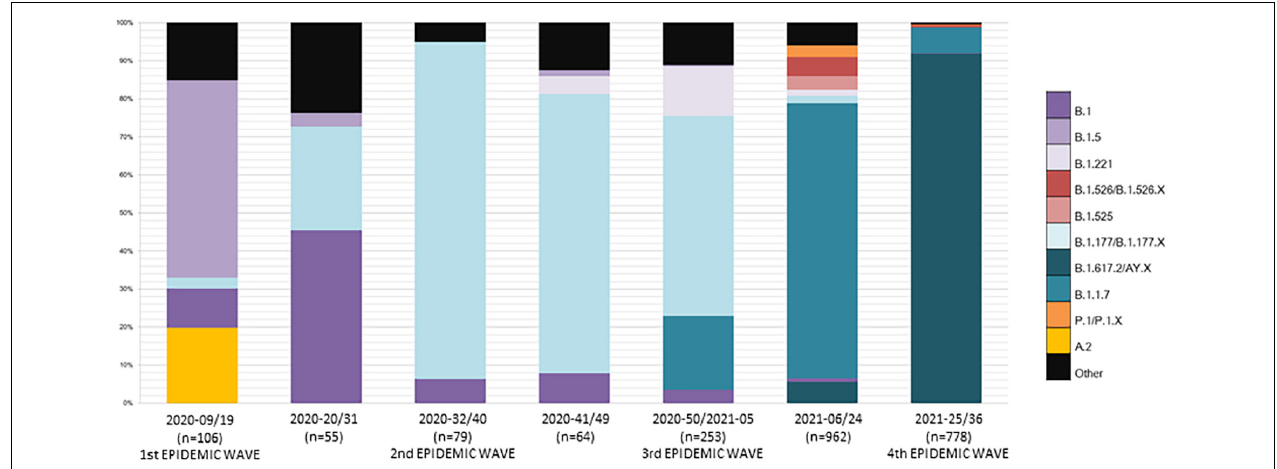
FIGURE 3 | Temporal evolution of SARS-CoV-2 lineages. Lineage distribution in each of the epidemic waves (and intermediate periods) registered in the Balearic Islands.